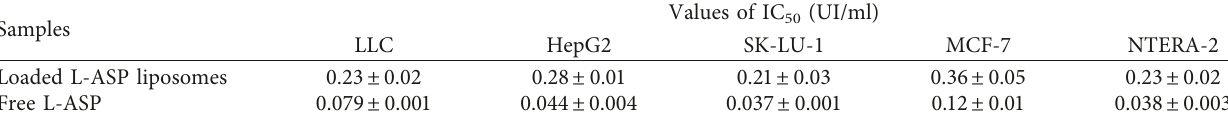
Table 3: Cytotoxic activities of L-ASP-encapsulated liposomes and free L-ASP on different cell lines. Samples